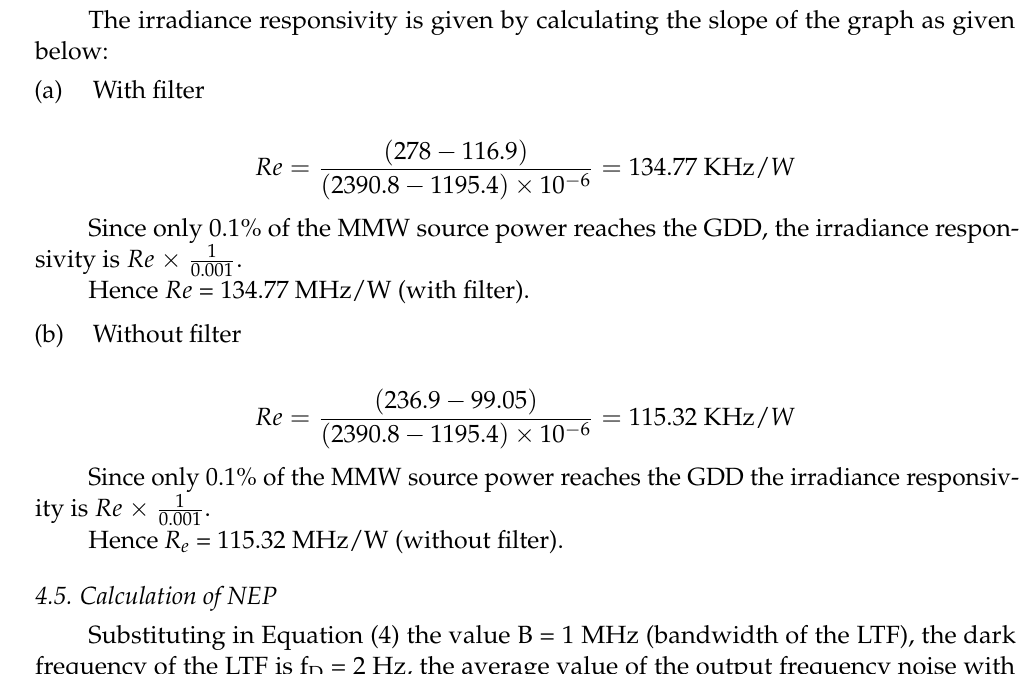
Figure 12. Difference in output frequency ∆ f mmw as a function of MMW radiation power hitting the cross section of the